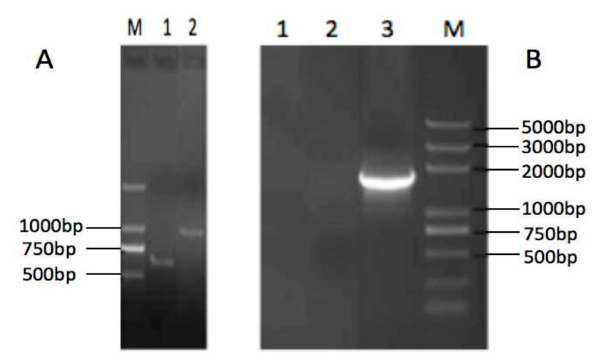
Figure 2. Agarose gel electrophoresis of the Tibetan pig IL-23 p40 and p19 subunits ( A ) (lane M: Trans 2K, lane 1: p19, lane 2: p40) and reverse transcription-polymerase chain reaction (RT-PCR) of VRIL23 transfected cells. ( B ) lane 1 and lane 2: negative control, lane 3: VRIL23.